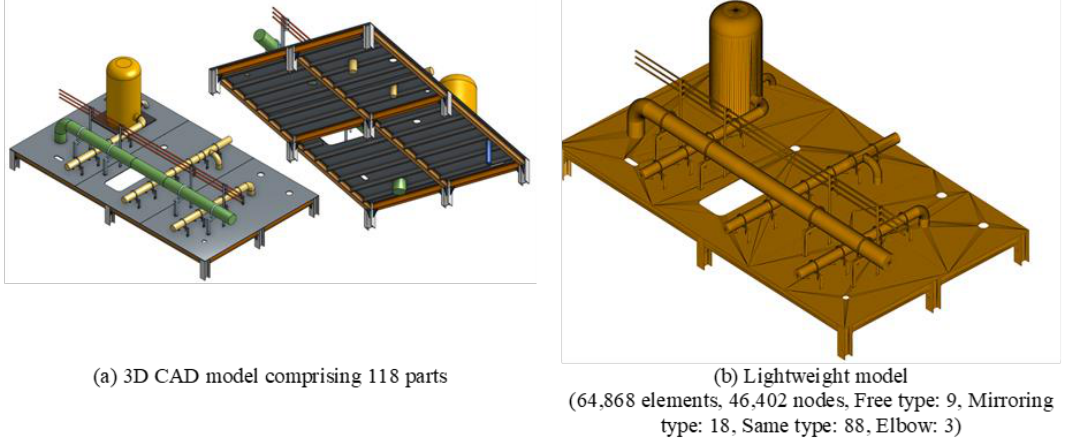
Figure 18. Data size minimization for offshore plant structure.